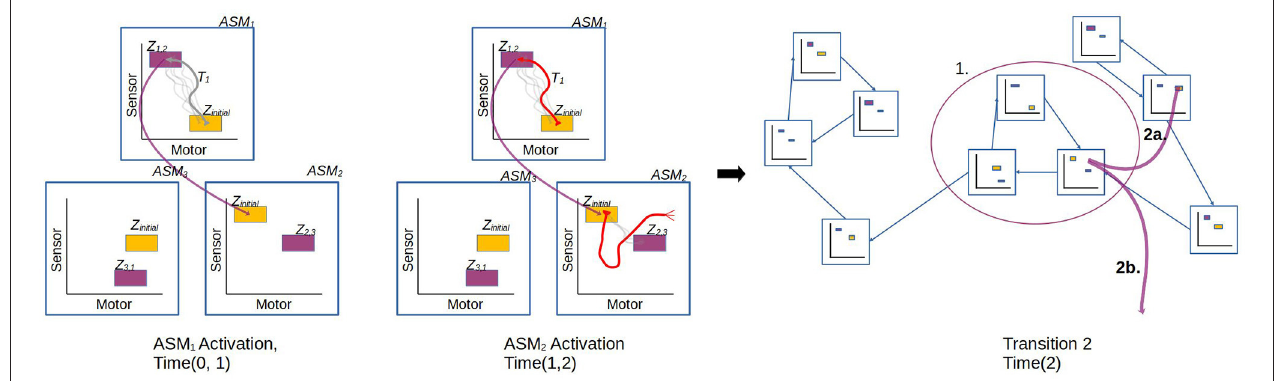
FIGURE 8 | Illustration of the transition process involved when an active ASM-unit succeeds ( ASM 1 ) or fails ( ASM 2 ) to establish the necessary sensorimotor conditions to make a transition that is associated with stable behavior. After ASM 1 ’s activation, the network transitions from ASM 1 to ASM 2 , which have an historically established link. After ASM 2 ’s activation, however, the conditions to transition from ASM 2 to ASM 3 are not present. The controller explores SM-space until a stable behavior is re-established. It could do this by either by transitioning to an ASM-unit which was not previously linked (2a.), or through random motor activity (2b.).